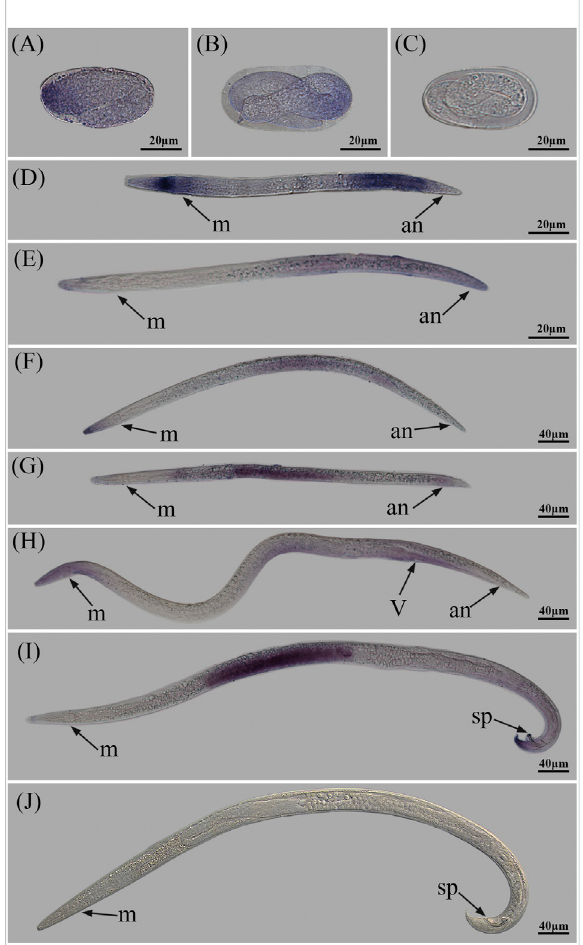
FIGURE 5 Localization of Bxy-laf-1 mRNA in B. xylophilus via in situ hybridization. Hybridization with the digoxigenin-labelled speci fi c probe in embryo (A,B) , no staining was observed in embryo (C) , second-stage juvenile (D) , third-stage juvenile (E) , female fourth-stage juvenile (F) , male fourth-stage juvenile (G) , female adult (H) ,andmaleadult (I) .Nostainingwasobservedinmaleadult (J) with control sense probes. a, anterior; p, posterior; m, metacorpus; an, anus; v, vulva; sp,